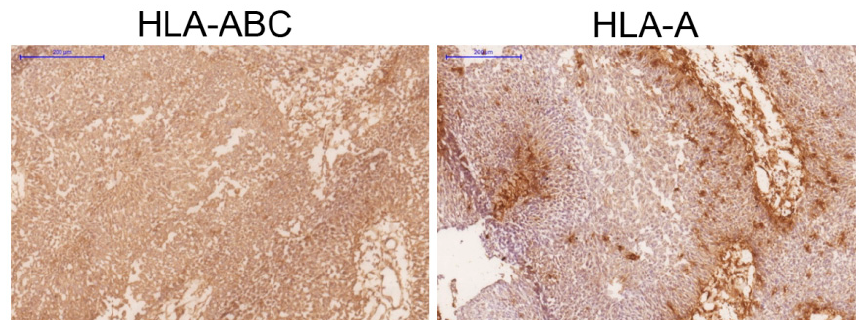
Figure 2. Immunohistological analysis of HLA class I expression in a bladder tumor tissue demon- strating a positive expression of total HLA - ABC / β 2M complex and a selective loss of HLA-A locus. Blue scale bar: 200 μ m.